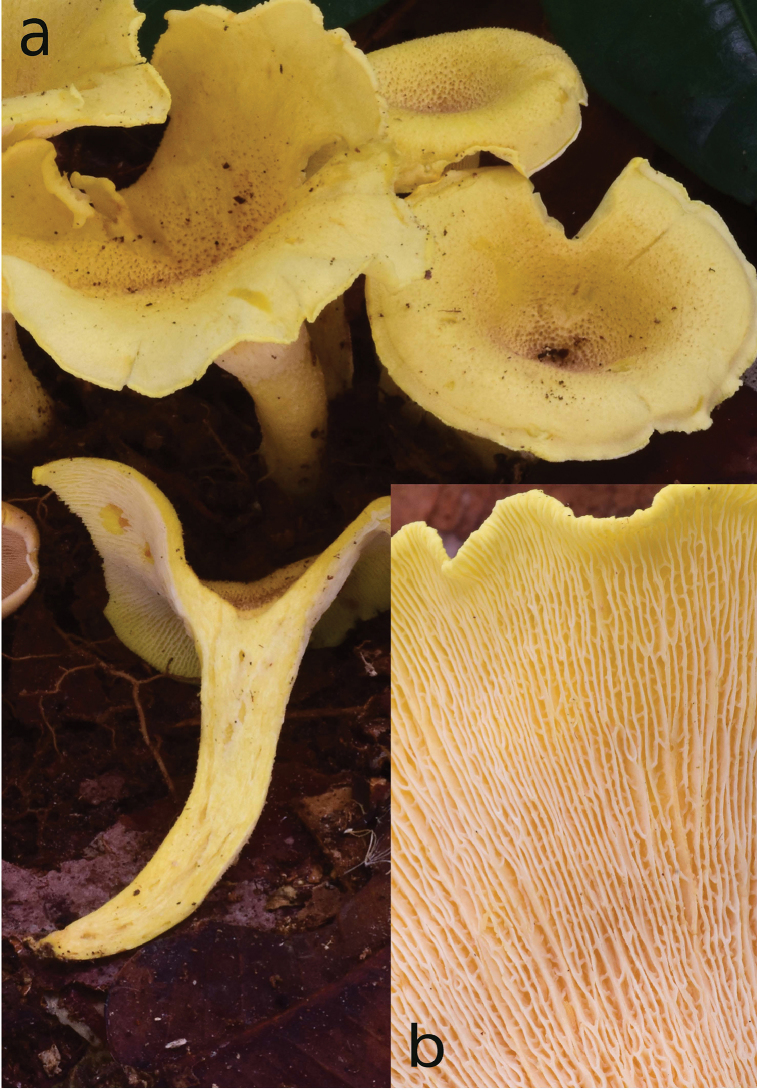
Cantharellusluteopunctatus (TH 10442). a Field habit of a collection that is more intensely yellow with distinctly yellowing context b detail of the hymenophore showing the crowded, thin and strongly anastomosing gill folds. Based on photos by Noah Siegel.